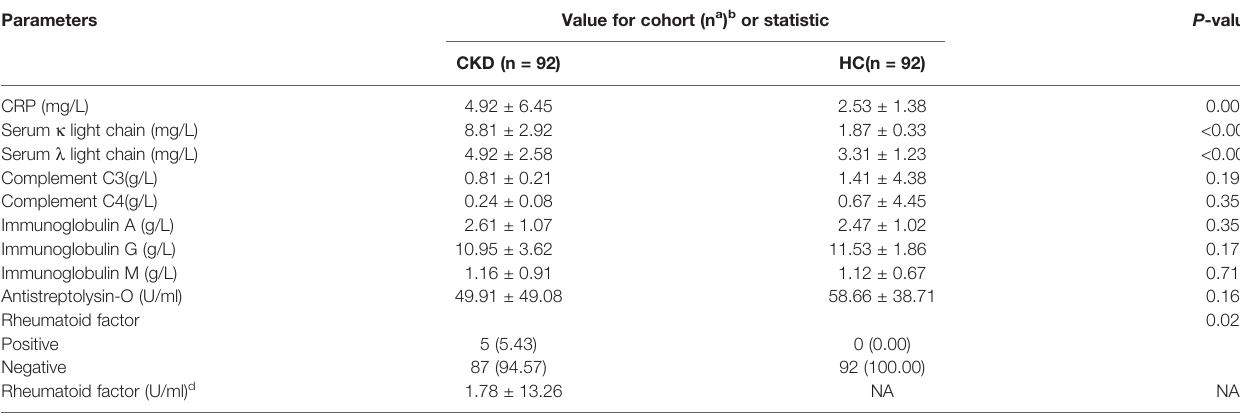
TABLE 2 | Comparison of immunological status between CKD and HC cohort. Parameters Value for cohort (n a ) b or statistic